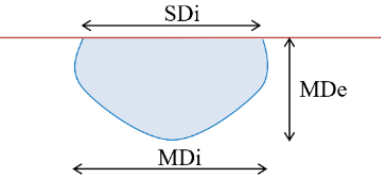
Figure 2. Dimensions of the bulb wetted by the dripper, SDi: surface dimension, MDi: maximum dimension, and MDe: maximum depth.